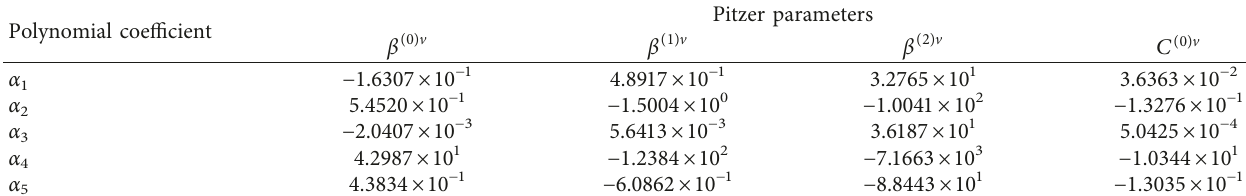
Table 6: The temperature-dependent equation coefficients of Pitzer parameters of NaAsO